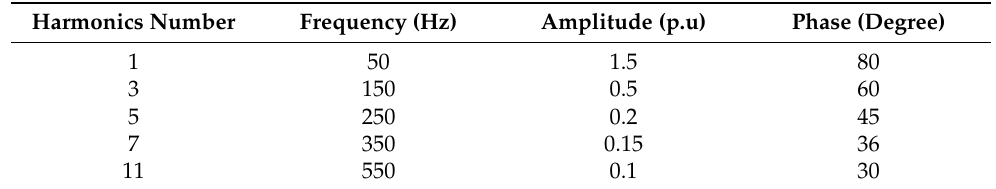
Table 2. Harmonic Contents of Actual Signal.